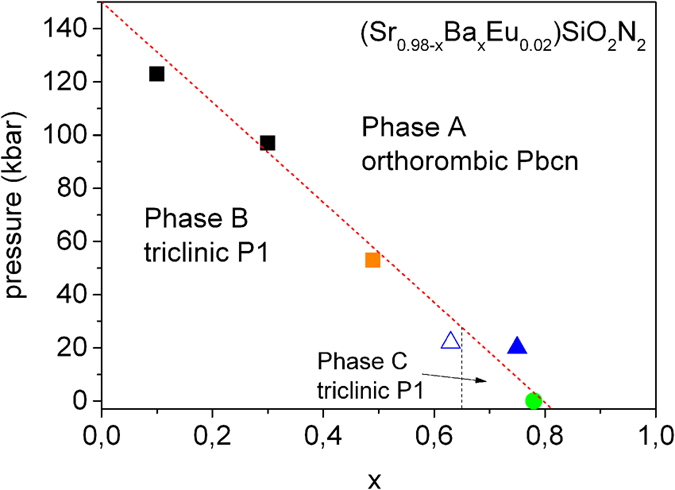
Phase diagram of (Sr0.98-xBaxEu0.02)Si2O2N2.